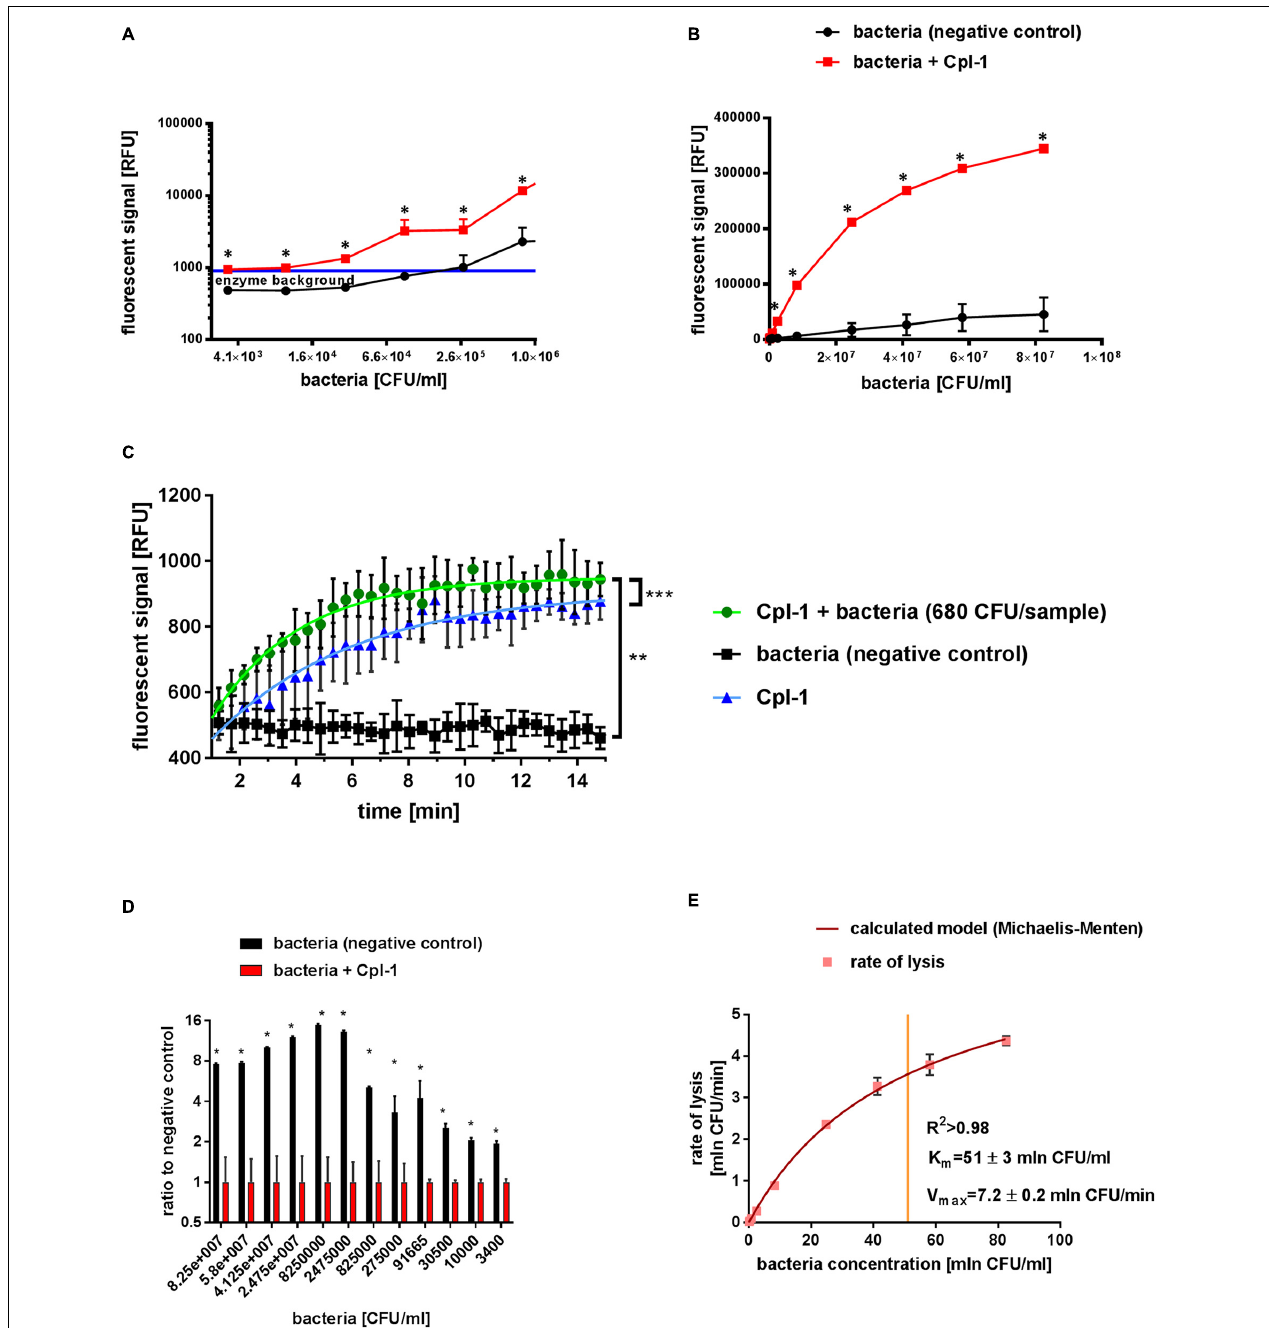
FIGURE 2 | Characteristics of Cpl-1 activity by fluorometric Sytox Green assay. The fluorescent signal was measured after 10 min lysis by Cpl-1 (5 mg/L) over a range of bacterial concentration from 1.6 × 10 7 CFU/sample to 6.8 × 10 2 CFU/sample. Bacterial lysis was detected in PBS (200 µ L) with bacteria at indicated concentrations and 0.25% Sytox Green solution. Fluorescent signal of Sytox Green after 10 min of bacterial lysis in low (A) and high (B) concentrations of bacteria (red) and background signal of bacteria with no endolysin (black). Blue line shows background signal of Cpl-1 alone. Kinetics of Cpl-1 activity in the lowest concentration of bacteria (680 CFU/sample) in comparison to background signals from bacteria (negative control) and Cpl-1 (C) . Ratio of signals from Cpl-1-lysed bacteria to negative control (bacteria) tested in a range of bacterial concentrations; the highest values represent optimal bacterial concentrations. (D) Graphical representation of a Michaelis-Menten model calculated for the Cpl-1 endolysin with experimental data (E) . * – statistically significant difference between samples and background ( p < 0.003). ** and *** signifies statistically significant difference between K values of plotted curves (** is p < 0.0001, and *** is p = 0.0269). Points or bars represent average of measurements for two independent experiments and whiskers represent the standard deviation.